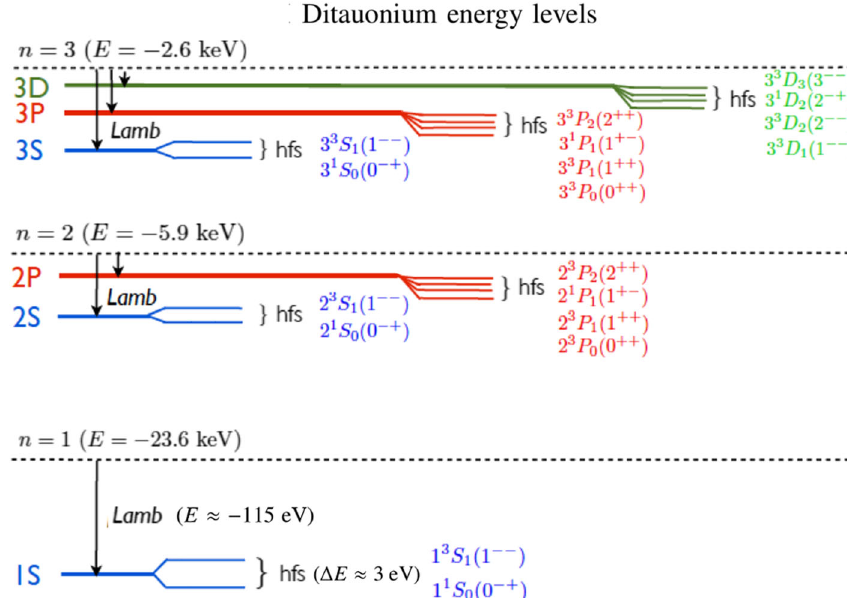
Fig. 3 Schematic representation of the ditauonium mass spectrum with the effects of the Lamb shift and leading hyperfine splitting contributions shown. For each state n 2 S + 1 L J , we also list their associated ( J PC ) quantum numbers. The sizes of each individual Lamb and hyperfine splitting are listed in Eqs. (6) and (9),